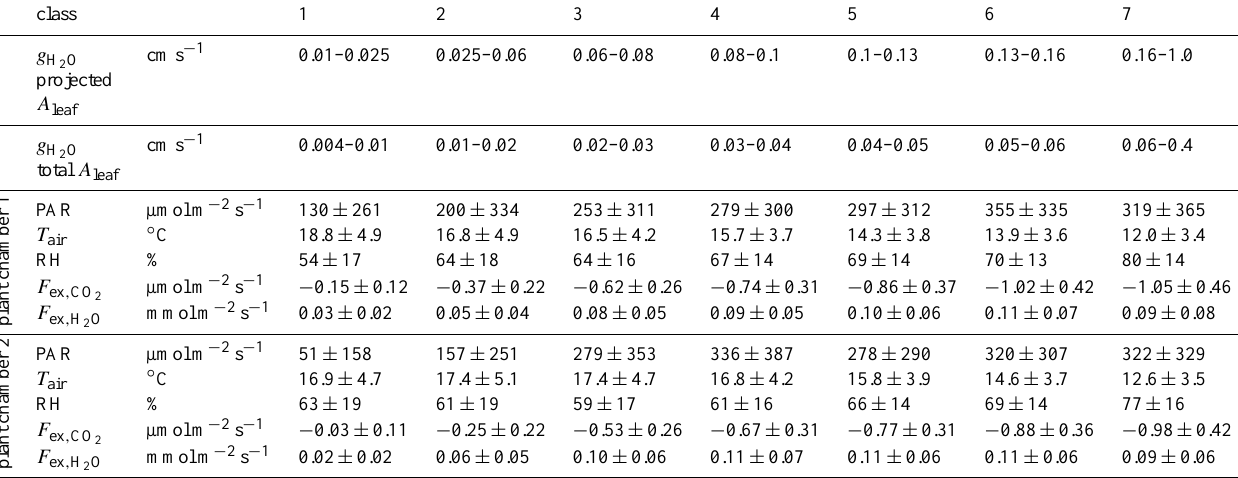
Table 3. Definition of the classes of leaf conductances, which were used for the classification of measured data. All displayed data are mean ) are listed once calculated on basis of projected leaf area and once on total leaf surface area. values. Leaf conductances ( g H 2 O